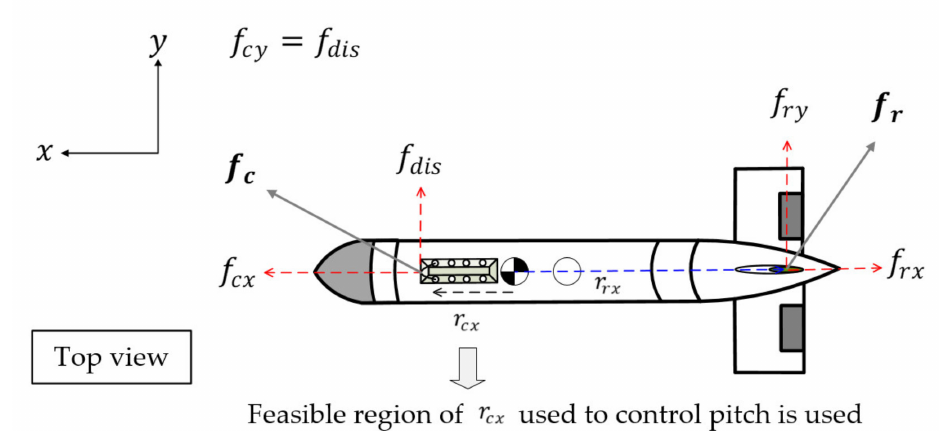
Figure 8. Forces acting on towfish in x − y plane (horizontal plane).